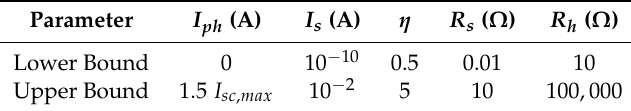
Table 1. Single-diode model (SDM) parameters physical bounds.